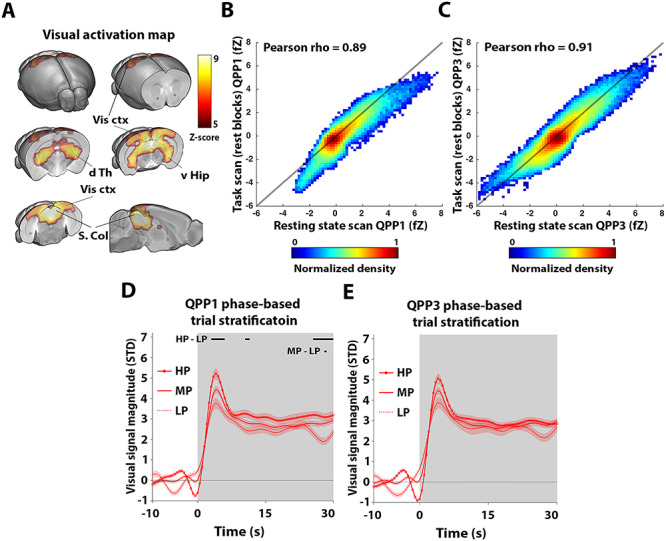
Phase of quasiperiodic brain fluctuations prior to stimulation stratify subsequent visual response magnitudes. Reliable visual activations were observed in brain areas related to visual sensory processing (A). A short 3-s QPP, highly similar to QPP1 determined during resting state scans, was observed during the rest blocks prior to stimulation in task scans (B). A consistent 9-s QPP was also observed (C). The phase of QPP1 (which displays activations in DMN-like areas) just prior to stimulation was used to stratify trials into 3 groups, respectively, depending on whether the phase was high (HP; [\documentclass[12pt]{minimal}
\usepackage{amsmath}
\usepackage{wasysym}
\usepackage{amsfonts}
\usepackage{amssymb}
\usepackage{amsbsy}
\usepackage{upgreek}
\usepackage{mathrsfs}
\setlength{\oddsidemargin}{-69pt}
\begin{document}
}{}$\pi /4$\end{document},\documentclass[12pt]{minimal}
\usepackage{amsmath}
\usepackage{wasysym}
\usepackage{amsfonts}
\usepackage{amssymb}
\usepackage{amsbsy}
\usepackage{upgreek}
\usepackage{mathrsfs}
\setlength{\oddsidemargin}{-69pt}
\begin{document}
}{}$3\pi /4$\end{document}]; i.e., “peaks”), low (LP; [−3\documentclass[12pt]{minimal}
\usepackage{amsmath}
\usepackage{wasysym}
\usepackage{amsfonts}
\usepackage{amssymb}
\usepackage{amsbsy}
\usepackage{upgreek}
\usepackage{mathrsfs}
\setlength{\oddsidemargin}{-69pt}
\begin{document}
}{}$\pi /4$\end{document},−\documentclass[12pt]{minimal}
\usepackage{amsmath}
\usepackage{wasysym}
\usepackage{amsfonts}
\usepackage{amssymb}
\usepackage{amsbsy}
\usepackage{upgreek}
\usepackage{mathrsfs}
\setlength{\oddsidemargin}{-69pt}
\begin{document}
}{}$\pi /4$\end{document}]; i.e., “valleys”), or medium (MP; [3\documentclass[12pt]{minimal}
\usepackage{amsmath}
\usepackage{wasysym}
\usepackage{amsfonts}
\usepackage{amssymb}
\usepackage{amsbsy}
\usepackage{upgreek}
\usepackage{mathrsfs}
\setlength{\oddsidemargin}{-69pt}
\begin{document}
}{}$\pi /4$\end{document},−\documentclass[12pt]{minimal}
\usepackage{amsmath}
\usepackage{wasysym}
\usepackage{amsfonts}
\usepackage{amssymb}
\usepackage{amsbsy}
\usepackage{upgreek}
\usepackage{mathrsfs}
\setlength{\oddsidemargin}{-69pt}
\begin{document}
}{}$3\pi /4$\end{document}] & [−\documentclass[12pt]{minimal}
\usepackage{amsmath}
\usepackage{wasysym}
\usepackage{amsfonts}
\usepackage{amssymb}
\usepackage{amsbsy}
\usepackage{upgreek}
\usepackage{mathrsfs}
\setlength{\oddsidemargin}{-69pt}
\begin{document}
}{}$\pi /4$\end{document},\documentclass[12pt]{minimal}
\usepackage{amsmath}
\usepackage{wasysym}
\usepackage{amsfonts}
\usepackage{amssymb}
\usepackage{amsbsy}
\usepackage{upgreek}
\usepackage{mathrsfs}
\setlength{\oddsidemargin}{-69pt}
\begin{document}
}{}$\pi /4$\end{document}]; i.e., “slopes”). This highlighted significant stratification of visual signal amplitudes by QPP1 at the transient response peak and end of the stimulation block (black bars in D). Using the phase of QPP3 prior to stimulation achieved similar stratifications as obtained for QPP1, but these were not significant (E). (A–E) n = 24 scans in 24 mice. (A) Maps display Z-scores (first level GLM; second level one-sample t-test; T-scores normalized to Z-scores; FDR P < 10–5]. (B, C) Scatter density plots of QPP fZ image intensities. (D, E) Gray areas mark trials (ON periods), traces show mean, and patches show standard error. Time traces are demeaned and variance normalized to 10-s OFF period prior to stimulation. Black bars indicate significant differences between trial groups [one-way ANOVA, FDR (#bins) P < 0.05; post hoc Bonferroni correction]. v Hip, ventral hippocampus; d Th, dorsal thalamus; Vis ctx, visual cortex; S. Col, superior colliculus; fZ, fisher Z-transformed.